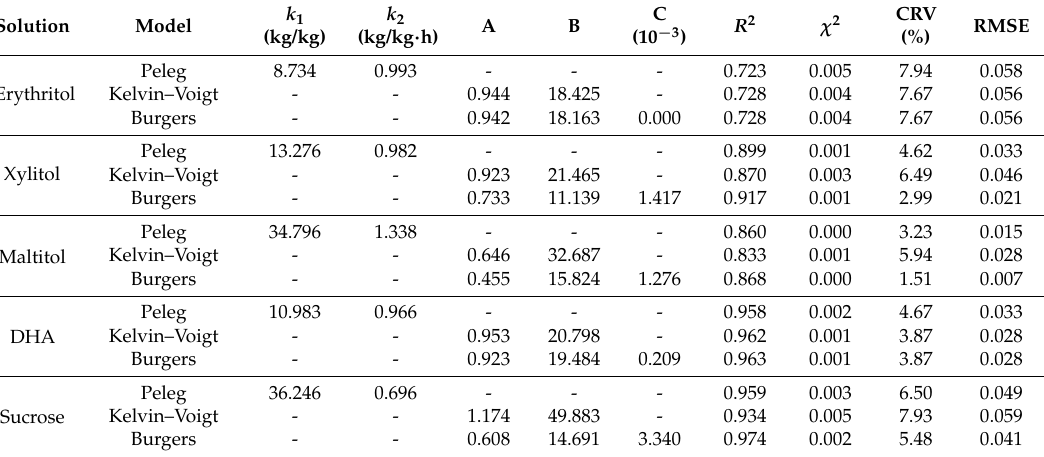
Table 8. The values of k 1 , k 2 , R 2 , χ 2 , CRV and RMSE of modeling WL T using Peleg’s, Kelvin–Voigt and Burgers model.